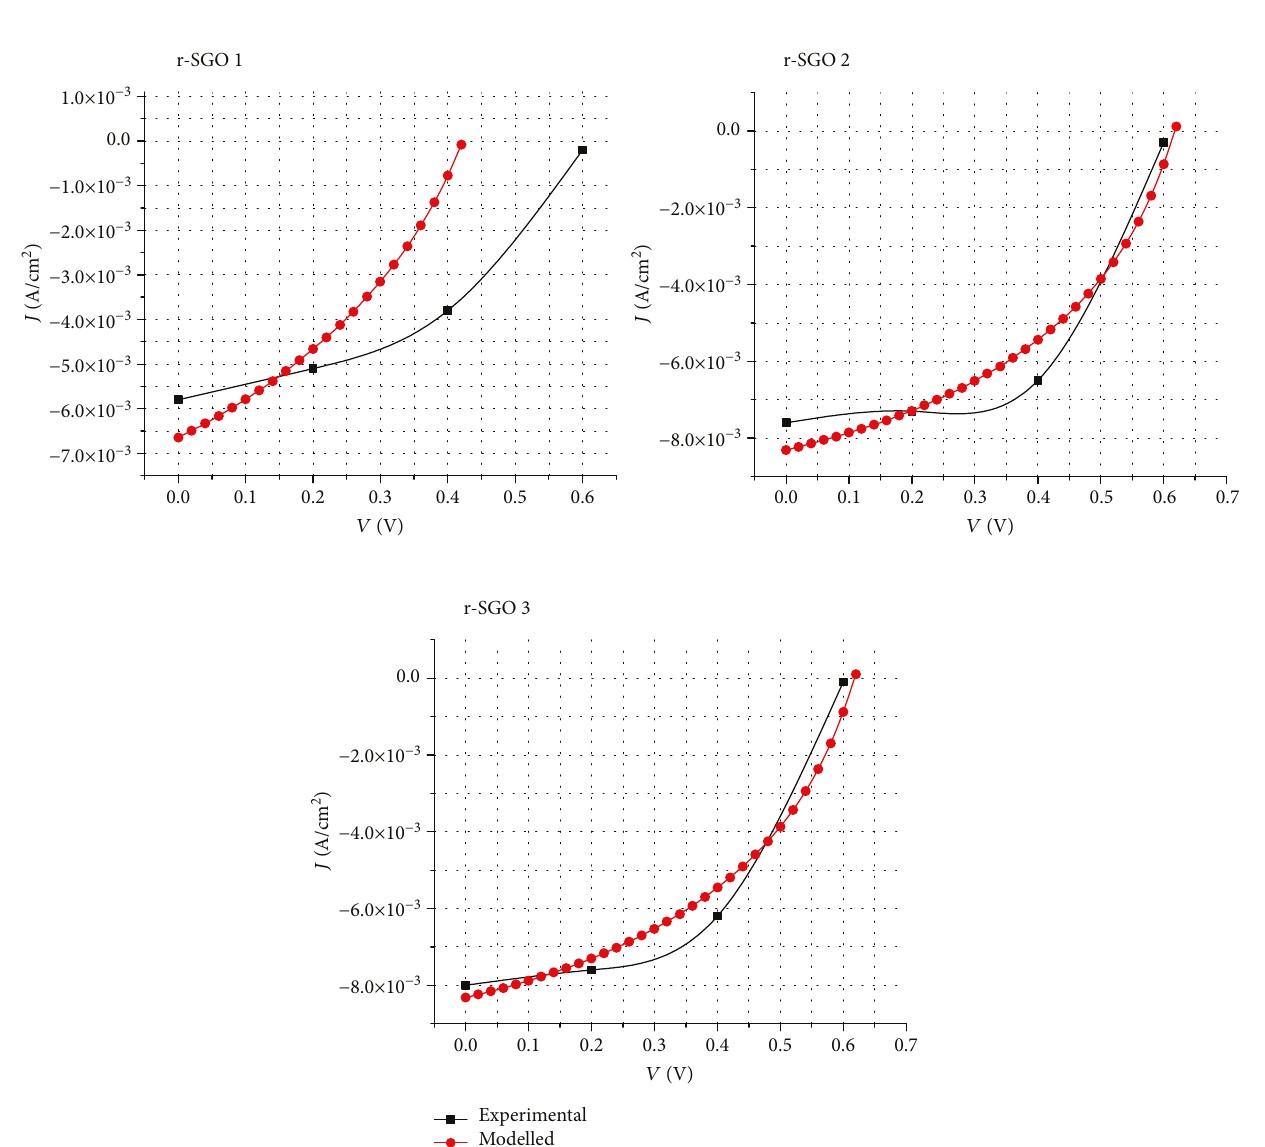
Figure 3: The experimental and modelled current density as a function of solar voltage for the devices under